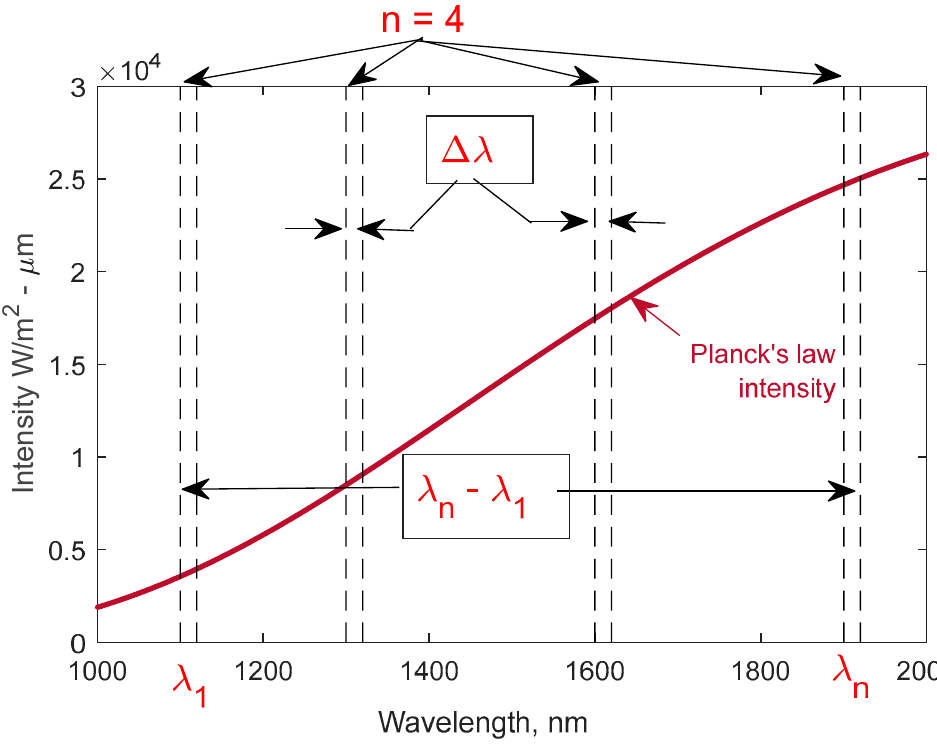
Figure 2. Wavelength parameters including number ( n ), spectral width or bandwidth ( ∆ λ j ), and adjacent spacing ( λ j – λ j − 1 ), where j : 1 to n and total spectral range ( λ n – λ 1 ) of the different regions must be selected and influence MRT analysis performance.